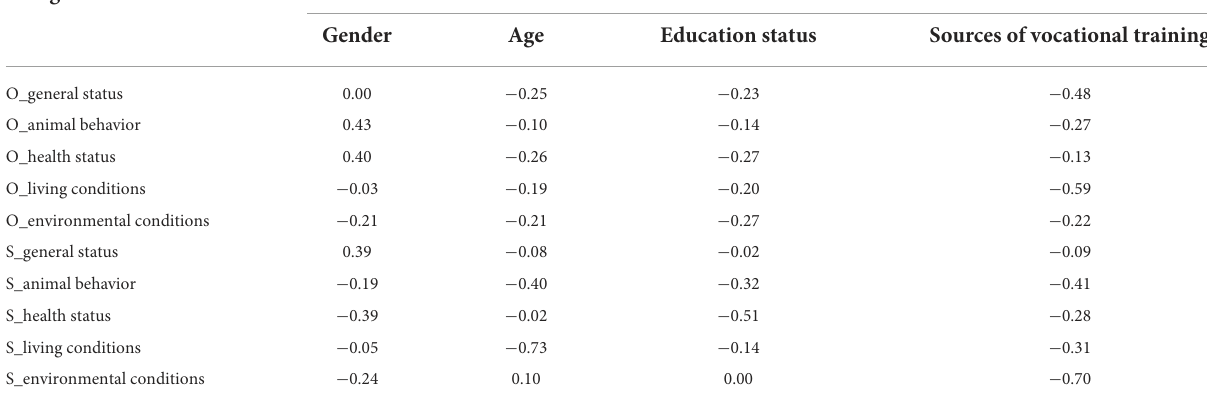
TABLE 5 Observational assessment and self-assessed importance of animal welfare effect sizes for gender, age, education level, and sources of vocational